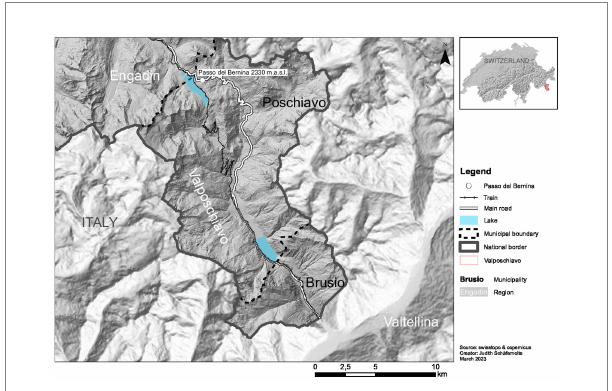
FIGURE 3 Map of Valposchiavo, created by the Judith